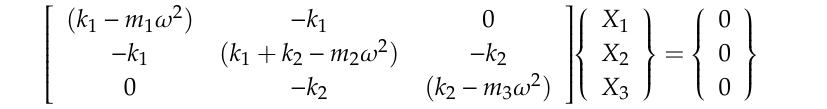
experimental and simulator results; ( b ) Simulation F-V curve according to continuous current inputs.